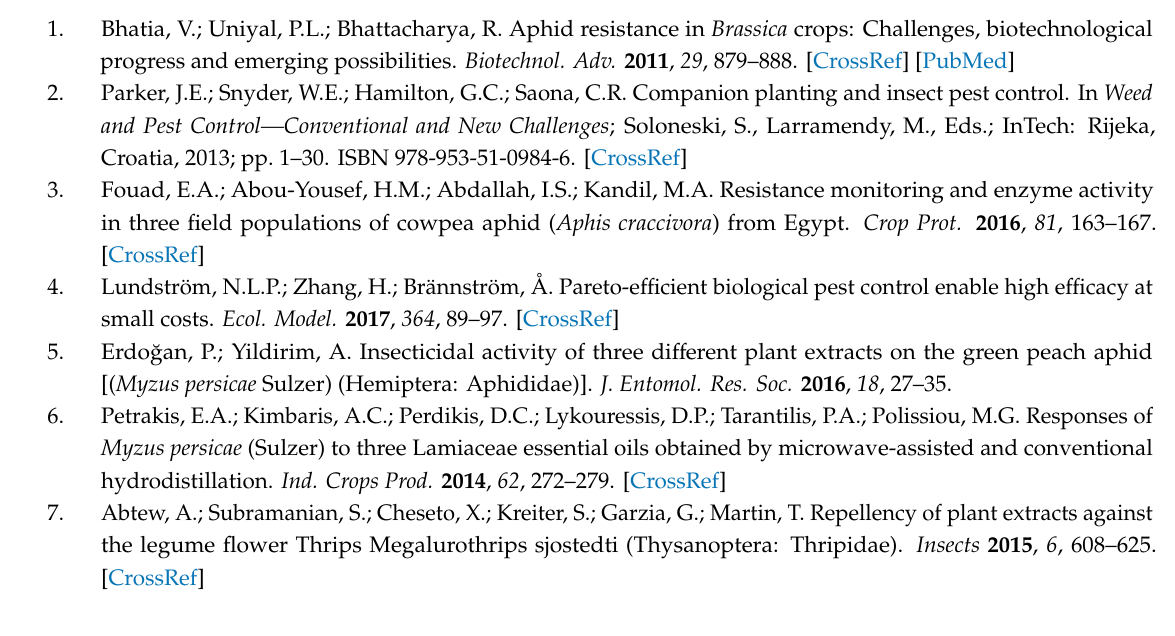
Table S1: Synthesis of analysis of the deviance (Anova) for fixed factors-plants, treatments and distance-and their interactions on abundance of each aphid species on amaranth plants, Table S2: Synthesis of analysis of the Ocimum repellent index on aphids at 8 and 12